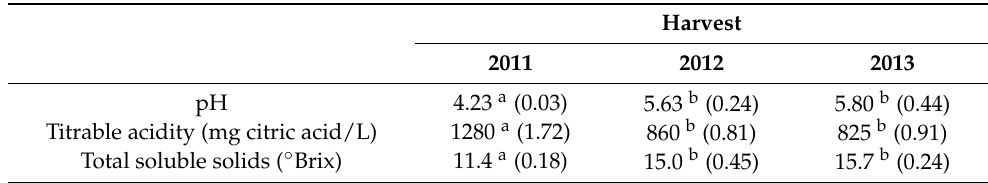
Table 1. General composition of La Mancha Trujillo melons. Mean values and relative standard deviations ( n = 2).